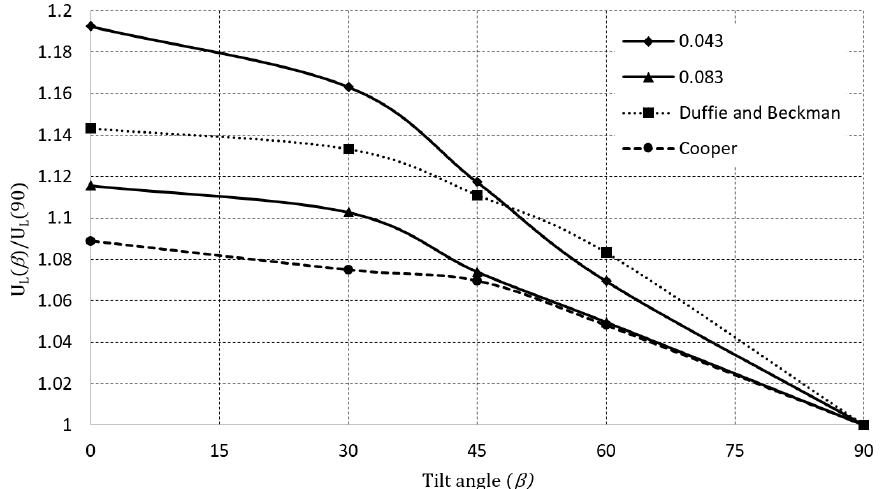
Figure 7. Comparison of U L ( β ) /U L (90°) vs. β and ( T i − T a )/ G at ( T o − T i ) > 0.